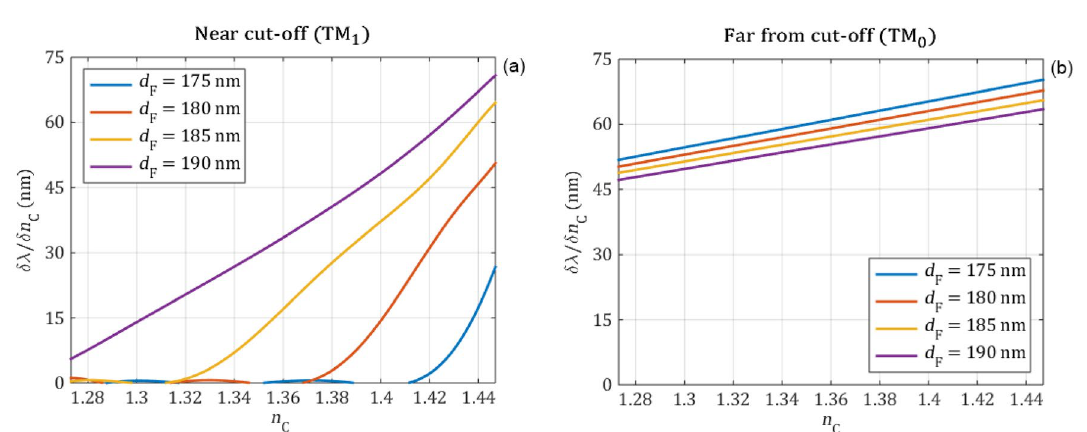
Figure 8. The sensitivity of the wavelength shift as a function of the refractive index of the cover medium for the near cut-off ( a ) and far from cut-off ( b ) resonant peaks at four different waveguide film thicknesses. The curves were created with derivation of a polynomial fitted curves of Fig. 6. It is clearly seen that while the wavelength sensitivity is almost constant in case of TM 0 (far from cut-off) peak, the sensitivity in case of TM 1 (near cut-off peak) decreases to zero approaching the cut-off